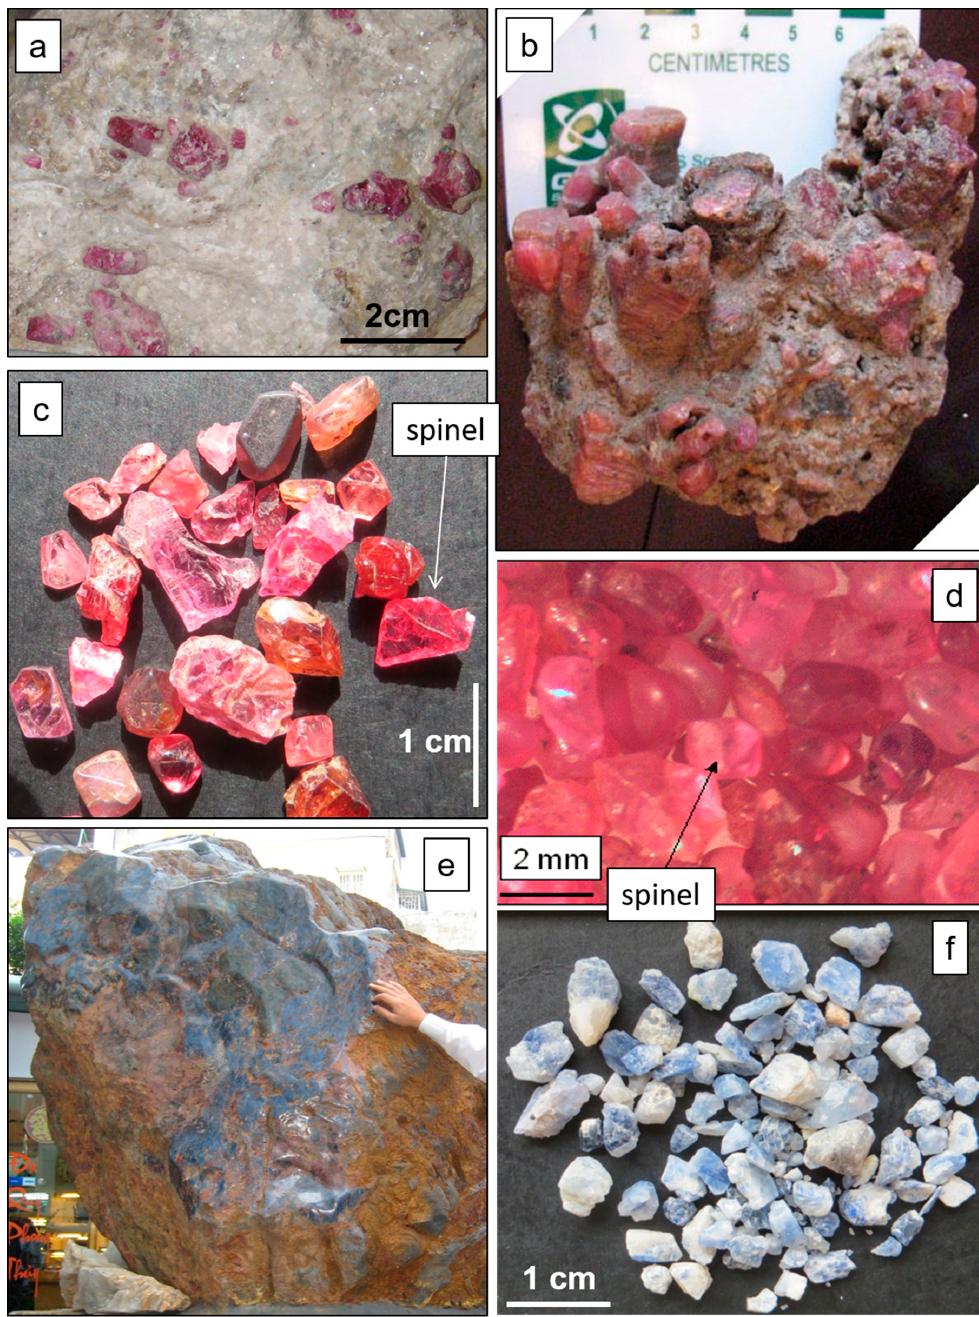
Figure 14. Precious corundum and spinel in placer deposits. ( a ) Euhedral to subhedral crystals of ruby in a pargasite-bearing marble (primary deposit), Vietnam. ( b ) Aggregate of ruby in a karst cavity of the marble, Vietnam, (residual placer). ( c ) Panned heavy minerals from a colluvial to alluvial placer of ruby and spinel (see octahedral crystal fragments), Vietnam. ( d ) Well-rounded grains of ruby with some subrounded octahedral of red spinel in a fluvial placer, Vietnam. ( e ) Sapphire measuring 12 tons by weight from a residual placer deposit, Vietnam. ( f ) Sapphire from a colluvial to alluvial placer, Madagascar.